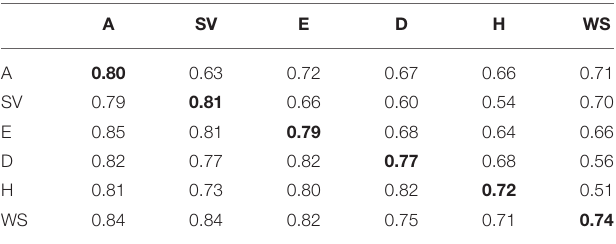
TABLE 5 | Average variance extracted, correlations, and squared correlations.